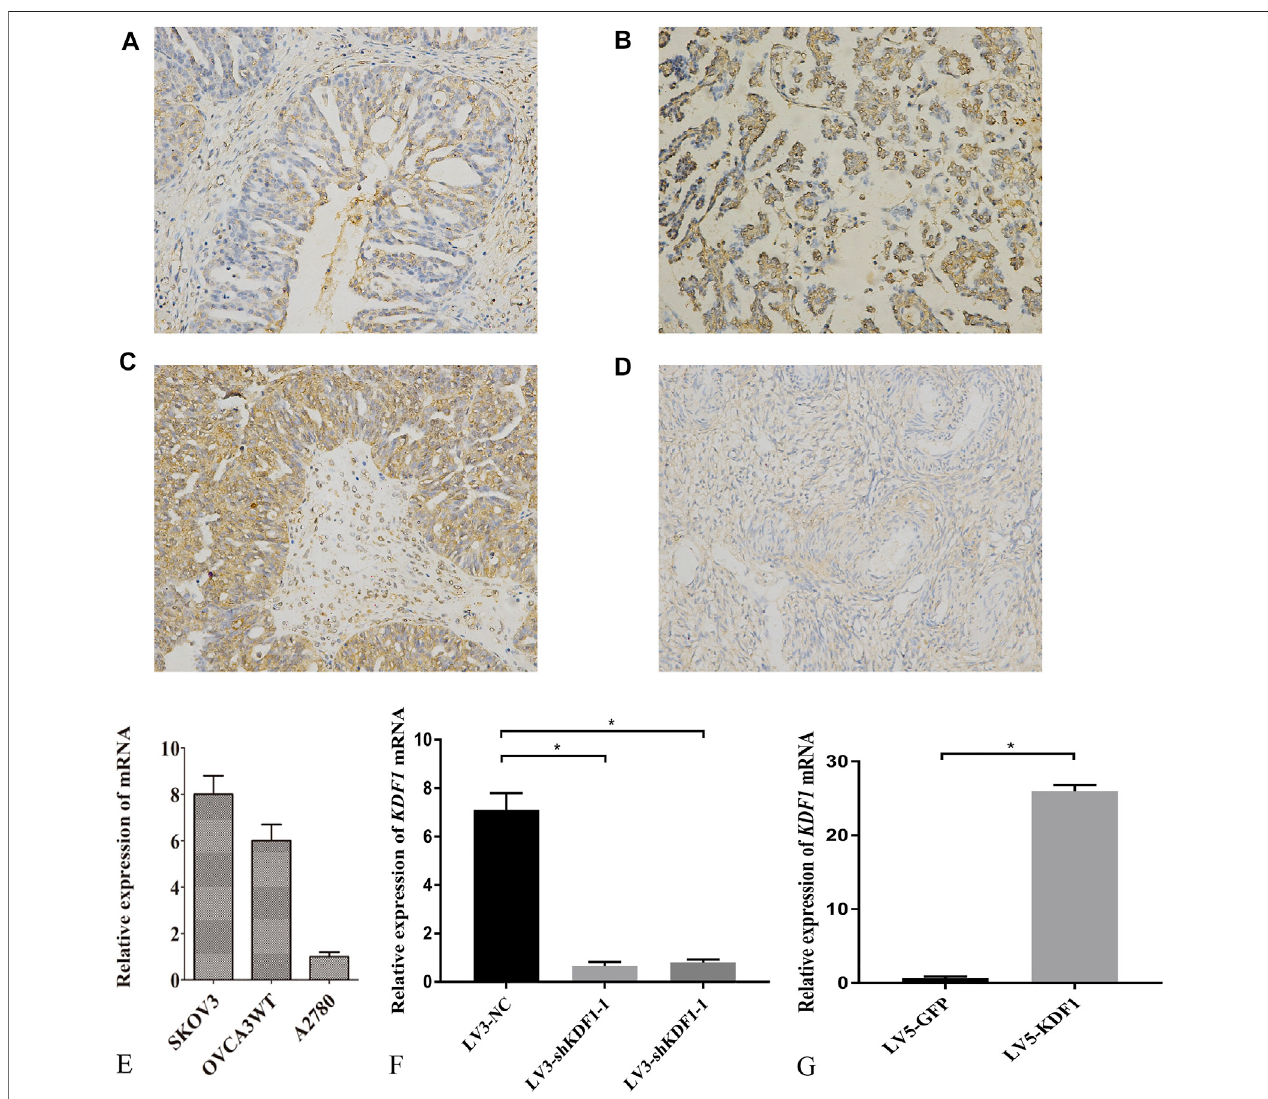
FIGURE 4 | Expression of KDF1 in tissues and cells of ovarian cancer. The expression and location of KDF1 was detected in ovarian cancer tissues (A – C) and normal ovarian tissues (D) . KDF1 mRNA expression was detected by RT-qPCR (E – G) . *indicates p < 0.05.